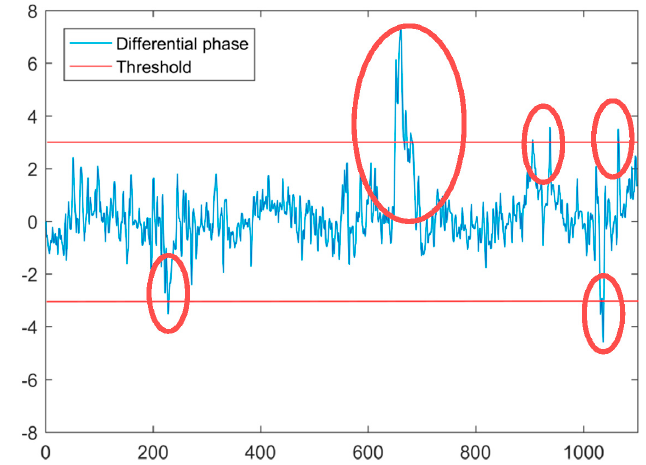
Figure 6. An azimuth profile (the red line in Figure 5a) of the difference between unwrapped and the fitted phases; the red lines are the phase thresholds.